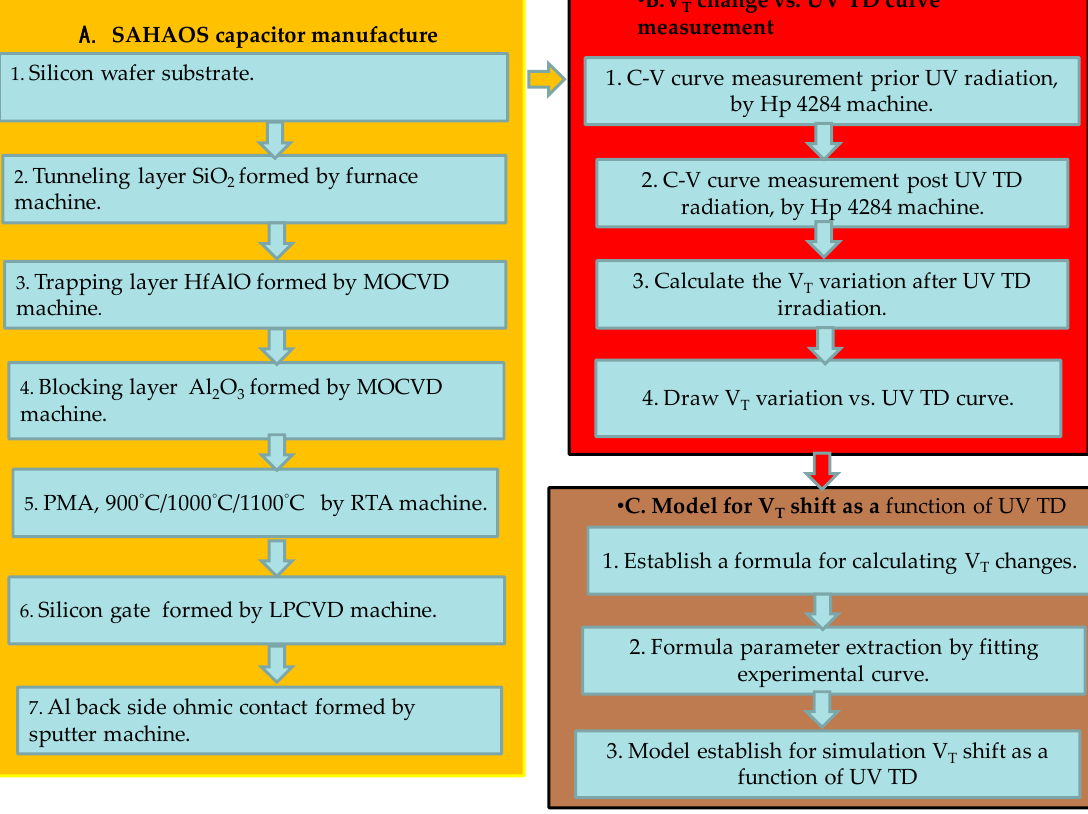
Figure 2. Experimental and simulation